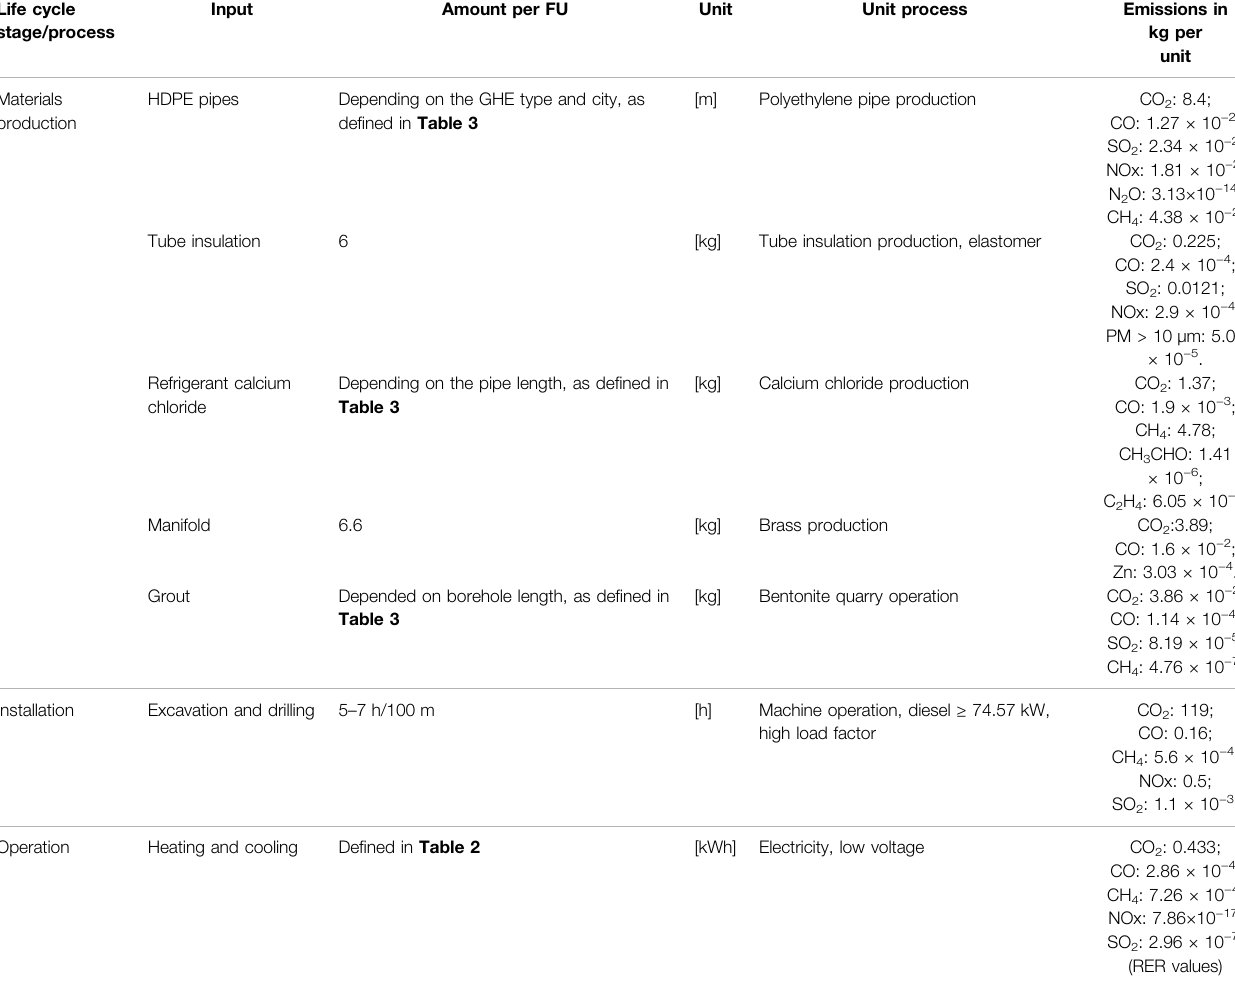
TABLE 1 | Life cycle inventory. Life cycle